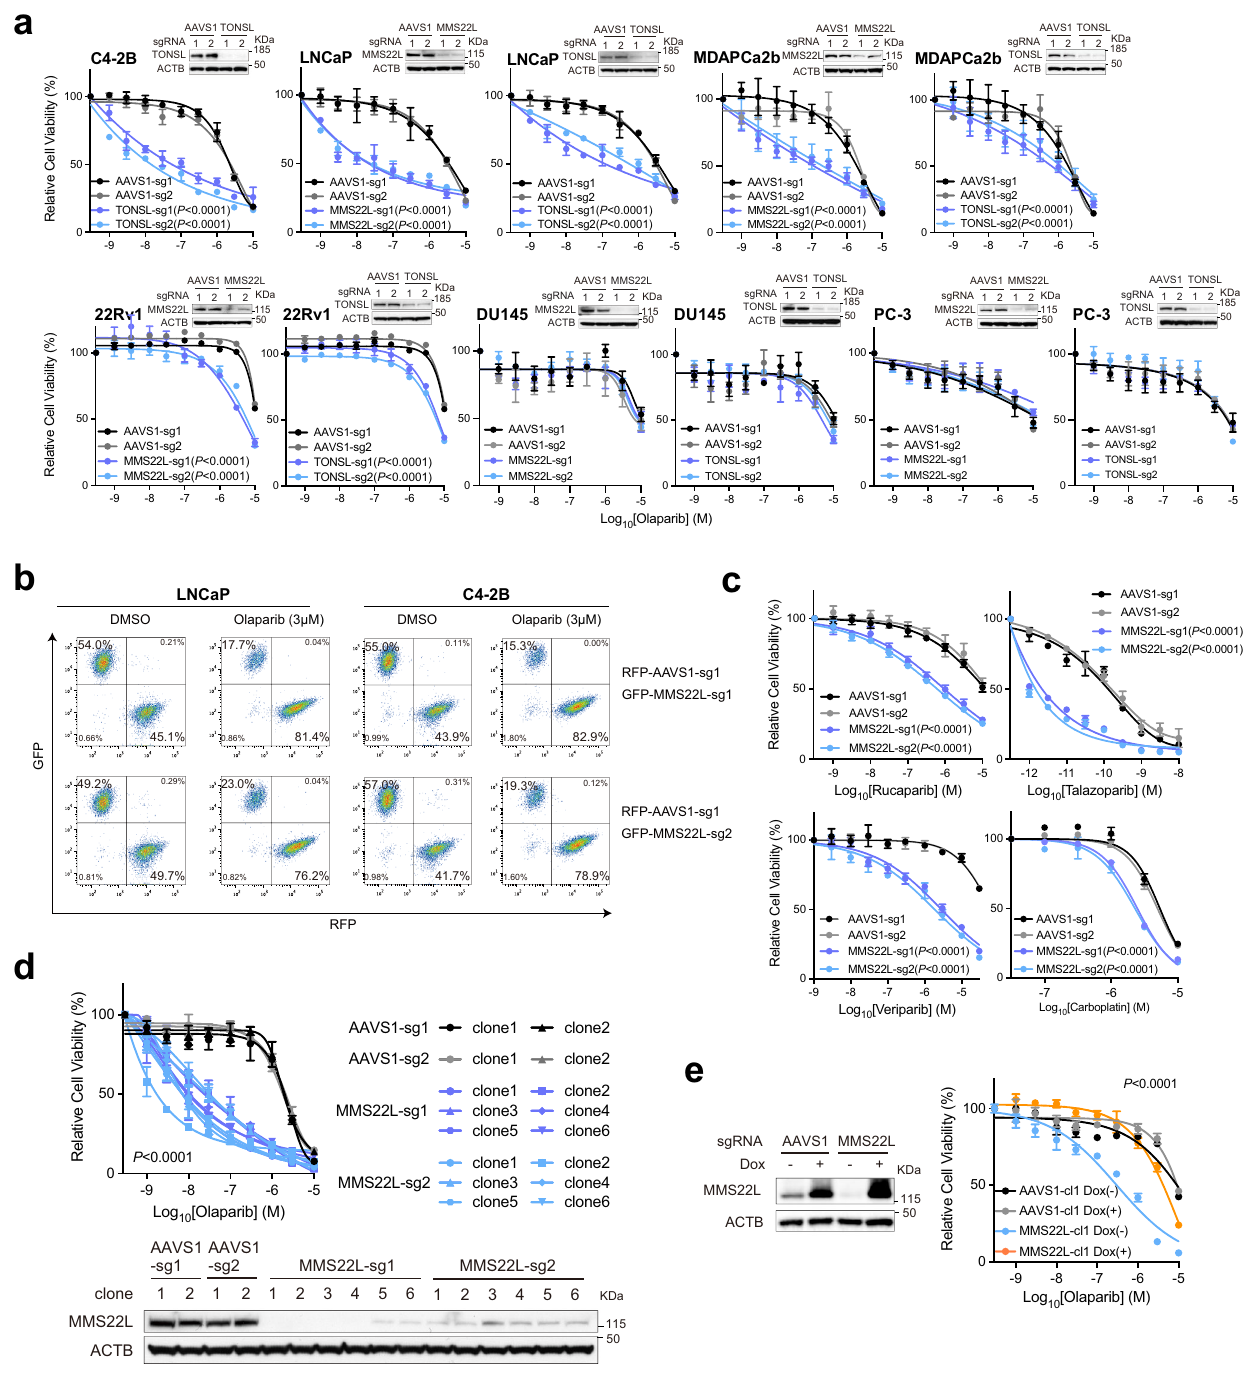
Fig. 3 | Loss of MMS22L increases PARPi response in PCa cells. a Dose-response curves after treatment with olaparib for MMS22L - or TONSL -KO cells versus corre- spondingAAVS1controlcellsofC4-2B,LNCaP,MDAPCa2b,22Rv1,DU145andPC-3. Upper right panels are immunoblot analysis of MMS22L or TONSL KO ef fi ciency. ACTB ( β -actin) is a loading control. The olaparib response of MMS22L -KO C4-2B cells is presented in ( 2b ). b Flow cytometry analysis of GFP and RFP positive cells. MMS22L -KO LNCaP or C4-2B cells(with GFP) were co-cultured with corresponding AAVS1 control cells (with RFP) in a 1:1 ratio in the presence of DMSO or olaparib. Two MMS22L -KO cell lines (sg1 and sg2) and one control cell line (sg1) were used.